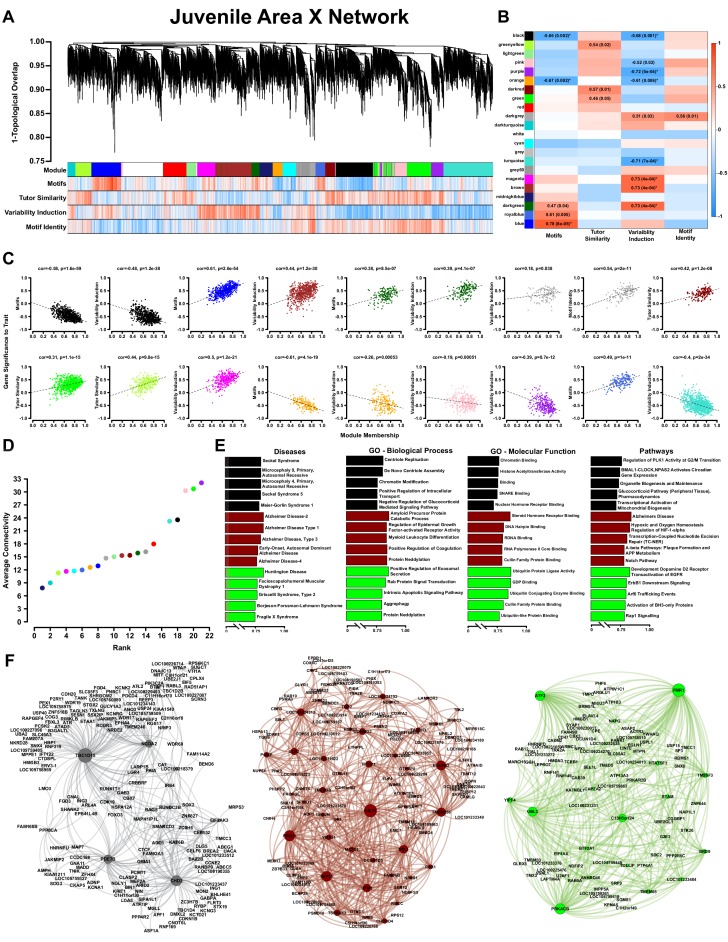
WGCNA yields behaviorally relevant modules.(A) Dendrogram (top) illustrates the topological overlap between genes in the juvenile Area X overall network. Modules delineated by automated tree trimming are shown below and are depicted by arbitrary colors. Beneath the color bar, gene significances to the quantified behaviors (number of motifs sung, tutor similarity, acute variability changes, and overall variability; see Results) are indicated by a heatmap wherein red indicates a positive correlation and blue indicates a negative correlation (see B for scale). (B) Correlations between module eigengenes and each behavior are presented as a heatmap. The Pearson’s ρ and, in parentheses, Student’s asymptotic p-values for modules where p≤0.05 are displayed. P-values are uncorrected for multiple hypothesis testing but those that pass FDR correction at p≤0.05 are denoted by * (See ‘Correlation of behavior to gene expression’ in Materials and methods). (C) For all significant module-trait correlations, the relationship between gene significance and module membership is plotted for each gene in the module. Dashed lines represent the linear regression and the Pearson’s ρ (‘cor’) and p-value as determined by Fisher’s z-transformation are indicated above each plot. (D) The average whole network connectivity (kTotal) within each module reveals that the purple, green, and pink modules are composed of the most strongly connected genes in the network. (E) Term significances for the black, darkred, and green modules are indicated for disease, gene ontology biological process and molecular function, as well as for pathways for categories annotated as ‘neuronal’ in the GeneCards GeneAnalytics software. (F) Network plots of the modules presented in panel E where nodes represent genes scaled by the node’s intramodular connectivity and edge width displays the topological overlap between genes.10.7554/eLife.30649.019Figure 3—source data 1.The behavioral metrics that were correlated to the network to generate (A) and (B).10.7554/eLife.30649.020Figure 3—source data 2.An R workspace containing the network presented in (A).10.7554/eLife.30649.021Figure 3—source data 3.An R workspace containing the processed expression data for the network presented in (A).10.7554/eLife.30649.022Figure 3—source data 4.The Pearson correlation values for each module eigengene and the behavioral metrics in Figure 3—source data 1.These data are the basis for panel 3B.